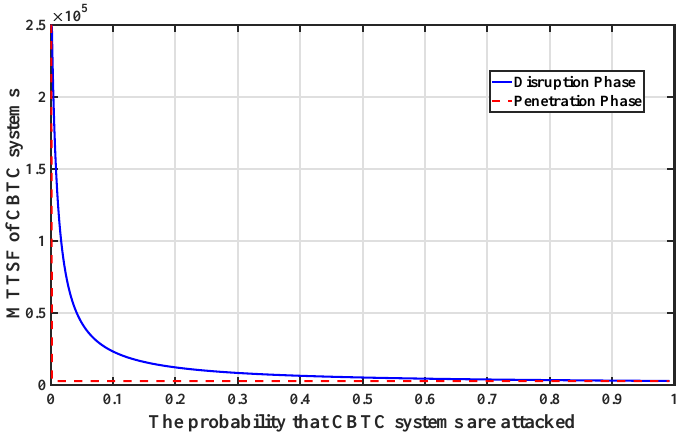
Figure 10. CBTC MTTSF with attack action